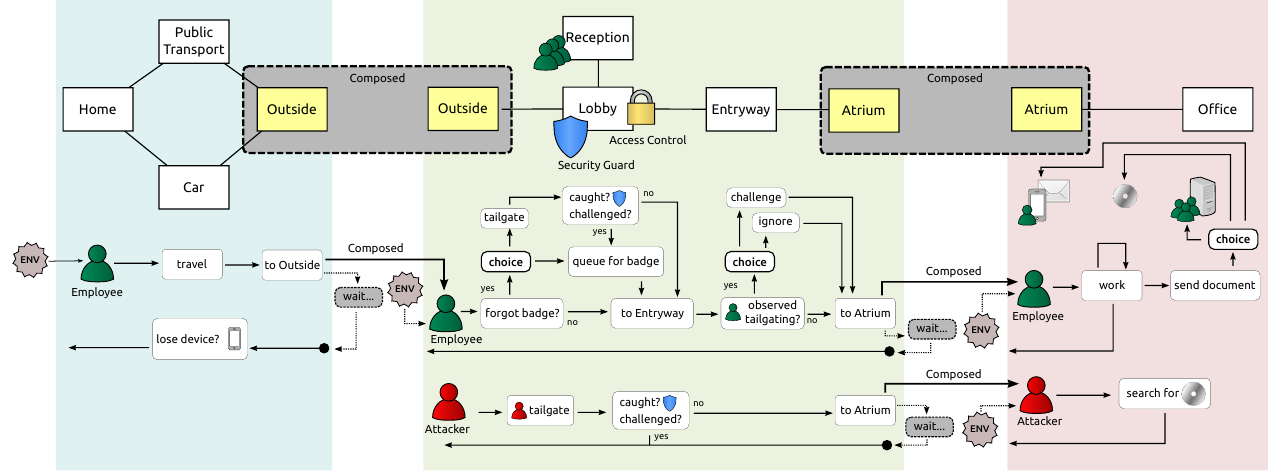
Figure 2: A depiction of the three example models, showing their locations and processes, and how the models are composed together